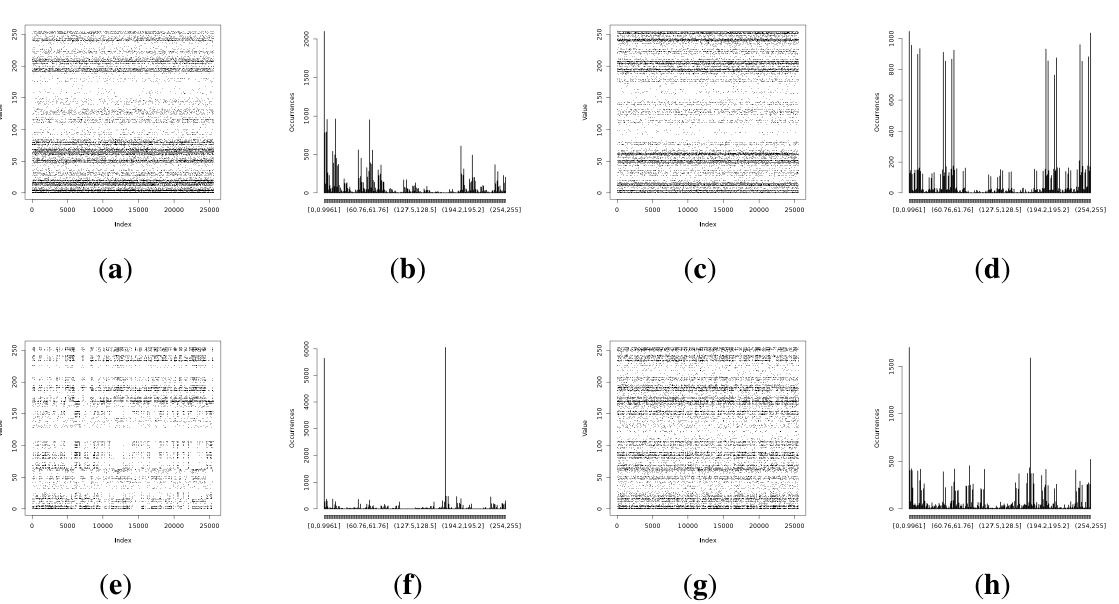
Figure 5. Initial experimental results of the harvested entropy by the second method in conjunction with the particular on-board sensor. ( a ) Light (1) sensor entropy; ( b ) distribution from the Light (1) sensor; ( c ) the Light (2) sensor entropy; ( d ) distribution from the Light (2) sensor; ( e ) humidity sensor entropy; ( f ) distribution from the humidity sensor; ( g ) temperature sensor entropy; ( h ) the distribution from the temperature